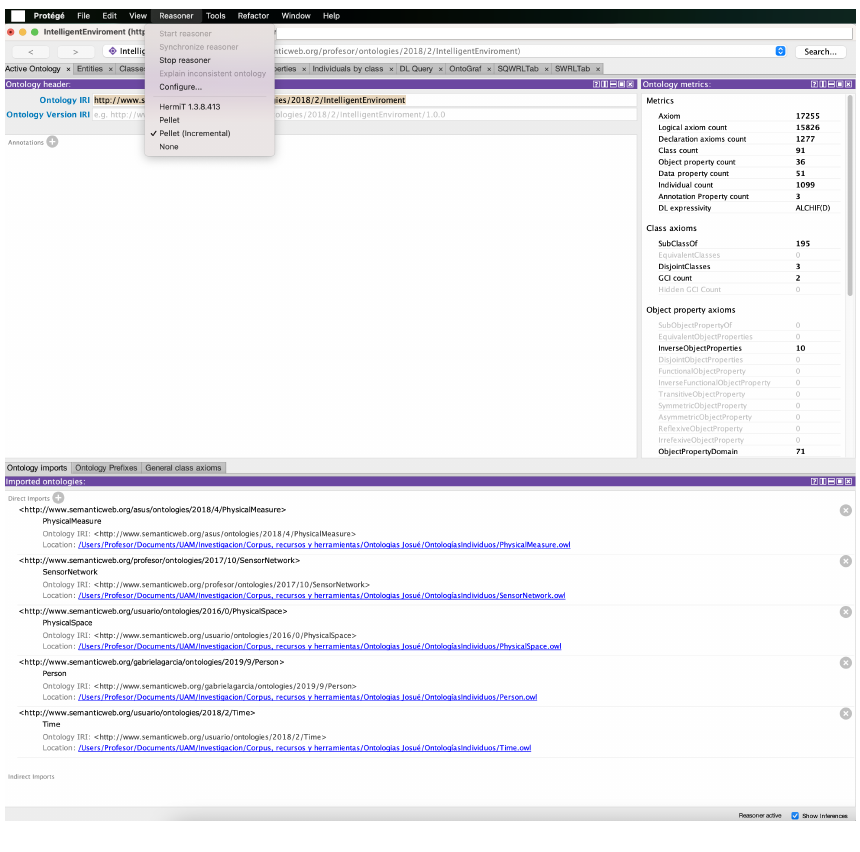
Figure 12. Verification of Ontology Clarity.